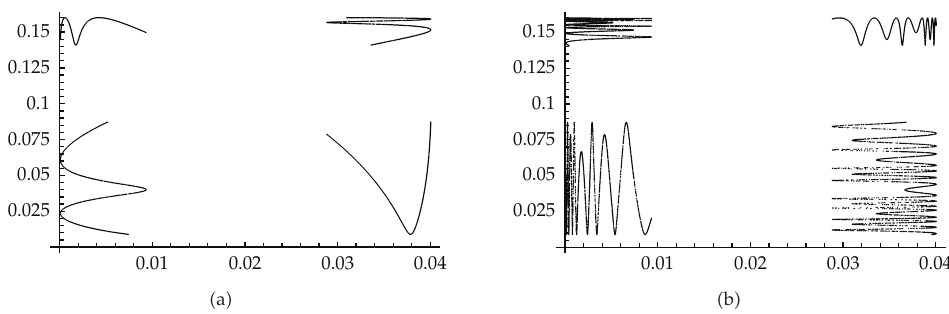
Figure 9: ω -limit sets for parameter value a (cid:6) 6 . 24 and k (cid:6) 6 (cid:4) a (cid:5) and k (cid:6) 16 (cid:4) b (cid:5)